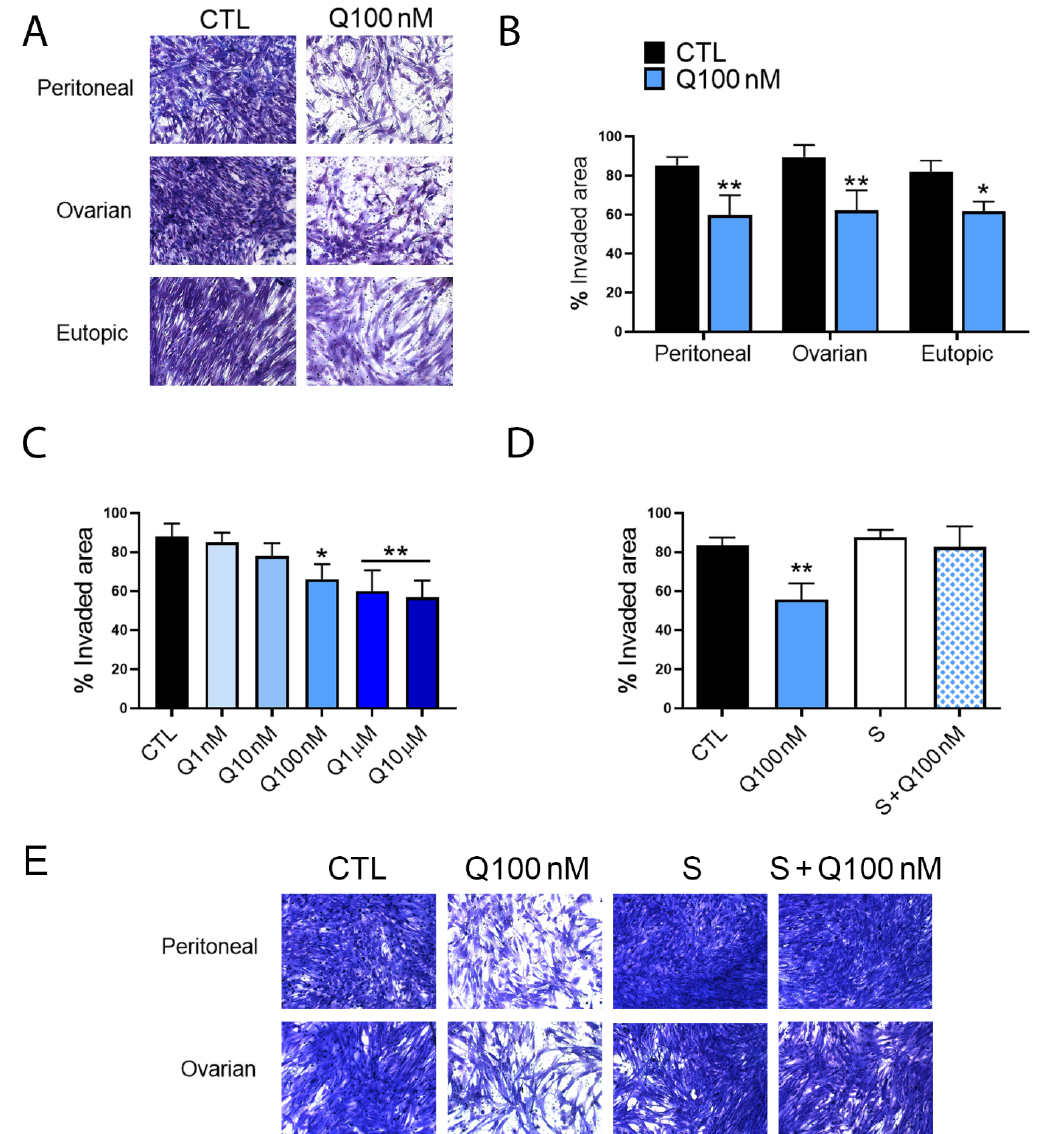
Figure 4. Quinagolide effect on E-MSC invasion. ( A , B ): Representative micrographs ( A ) and quantification ( B ) of quinagolide effect (100 nM) on eutopic and ectopic (both ovarian and peritoneal) E-